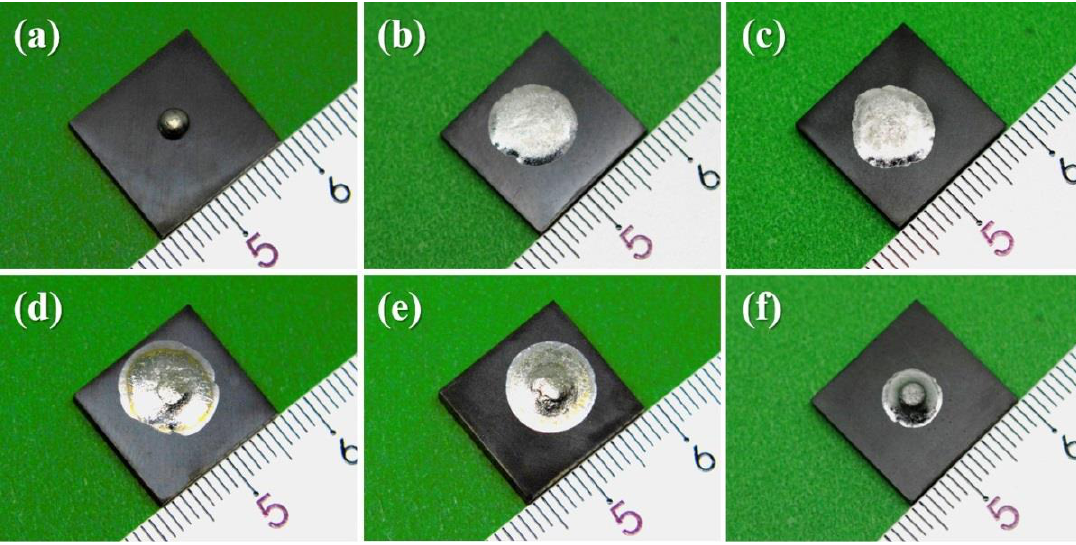
Figure 2. Wetted Samples cooled from 950 °C: ( a ) Sn, ( b ) Sn-0.5V, ( c ) Sn-1V, ( d ) Sn-3V, ( e ) Sn-5V, and ( f ) Sn-7V (in wt.%).